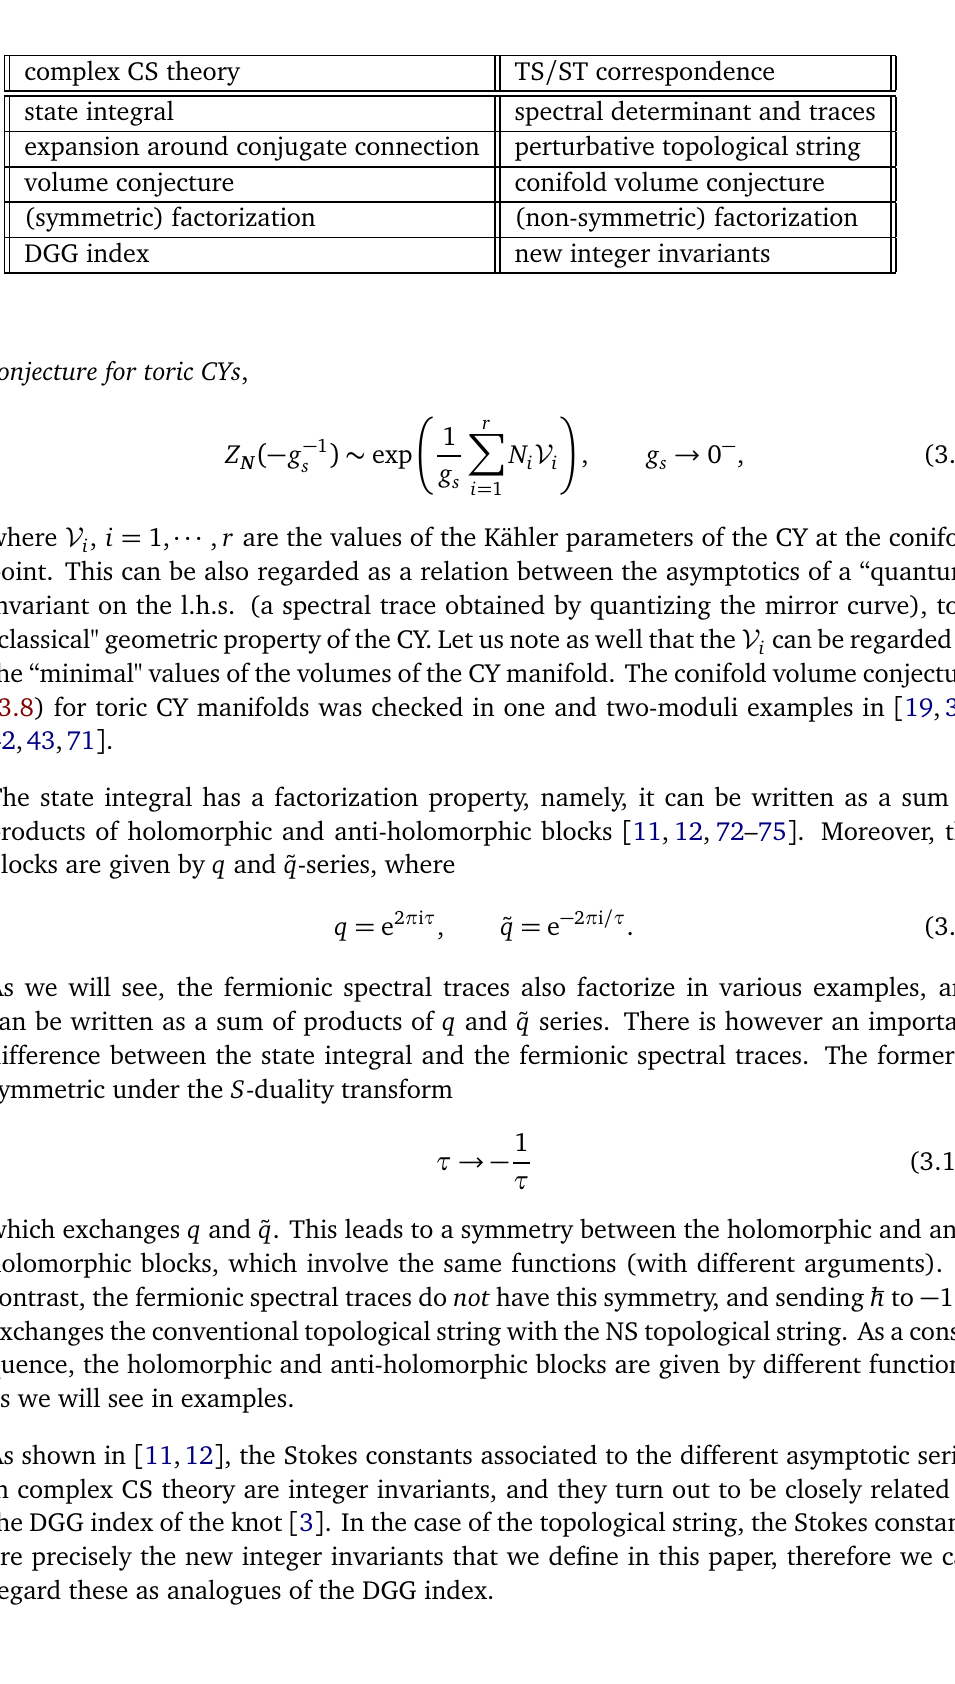
Table 1: Similarities between structures appearing in complex CS theory and in the TS / ST